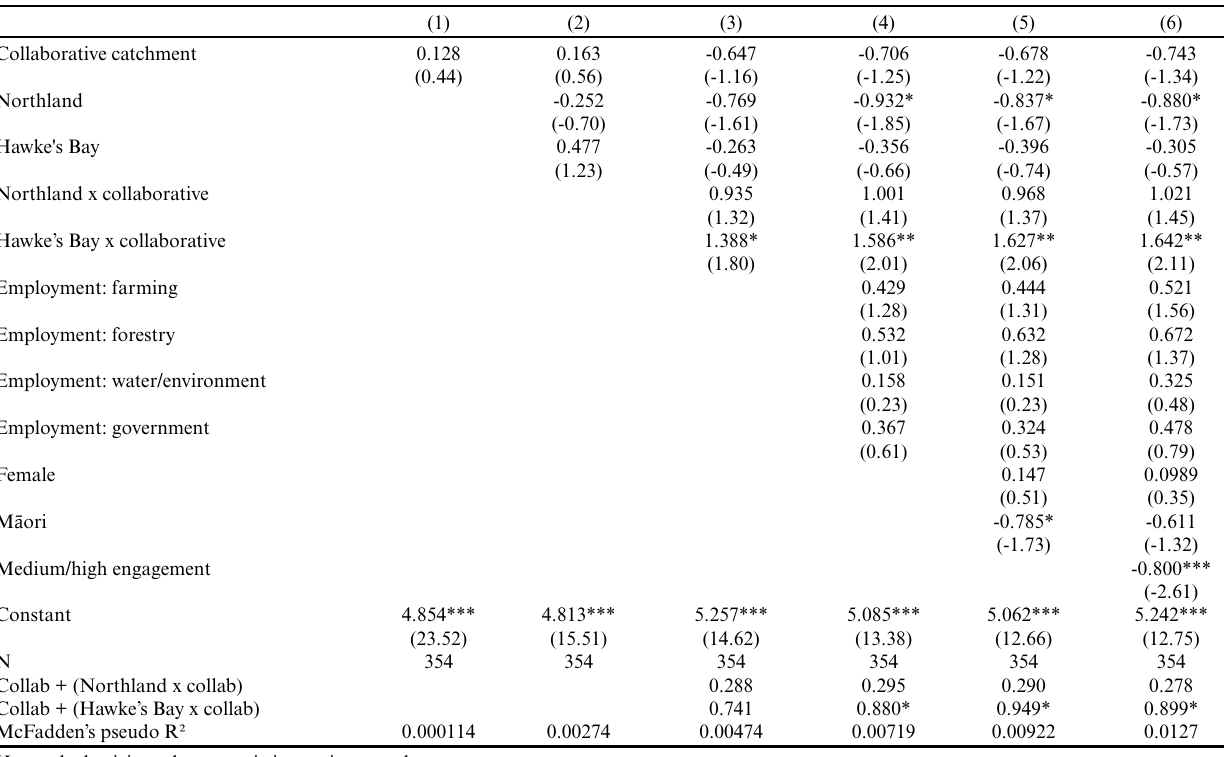
Table 2 . Perceptions of regional councils’ management (“Using a scale from 0 to 10, where 0 means very poorly and 10 means very well, in your opinion how well does the [name of regional council] manage freshwater